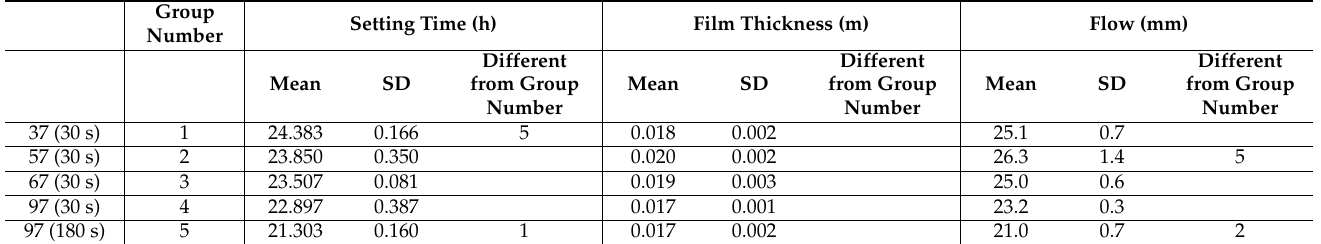
Table 4. Physical properties in accordance with ISO 6876 of Total Fill BC Sealer (means and standard deviations (SD)) after thermal treatment. Statistical analysis of setting time, film thickness, and flow for Total Fill BC Sealer was performed by Kruskal–Wallis test ( p < 0.05).